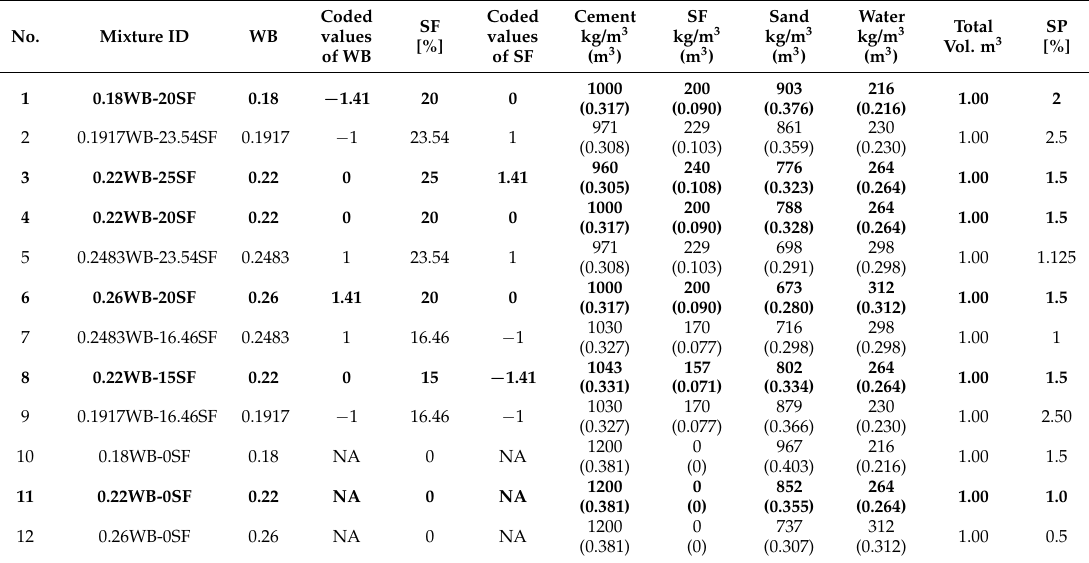
Table 2. Mixture proportion of Reactive Powder Concrete (RPC) (kg/m 3 ) and response surface method (RSM)